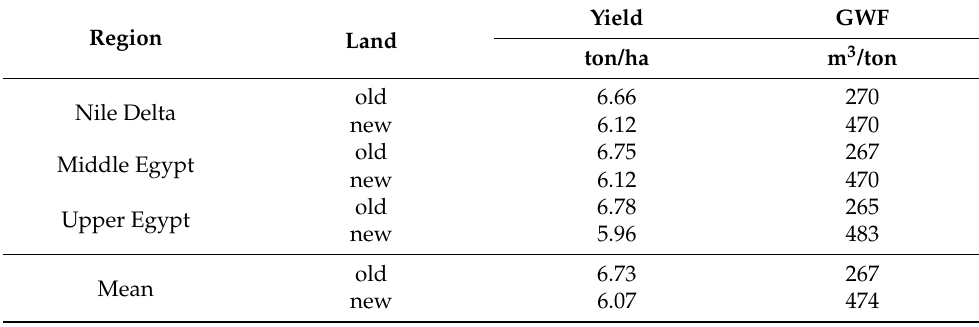
Table 6. Maize yield and grey water footprint for three climate regions in old and new land. Region Land Nile